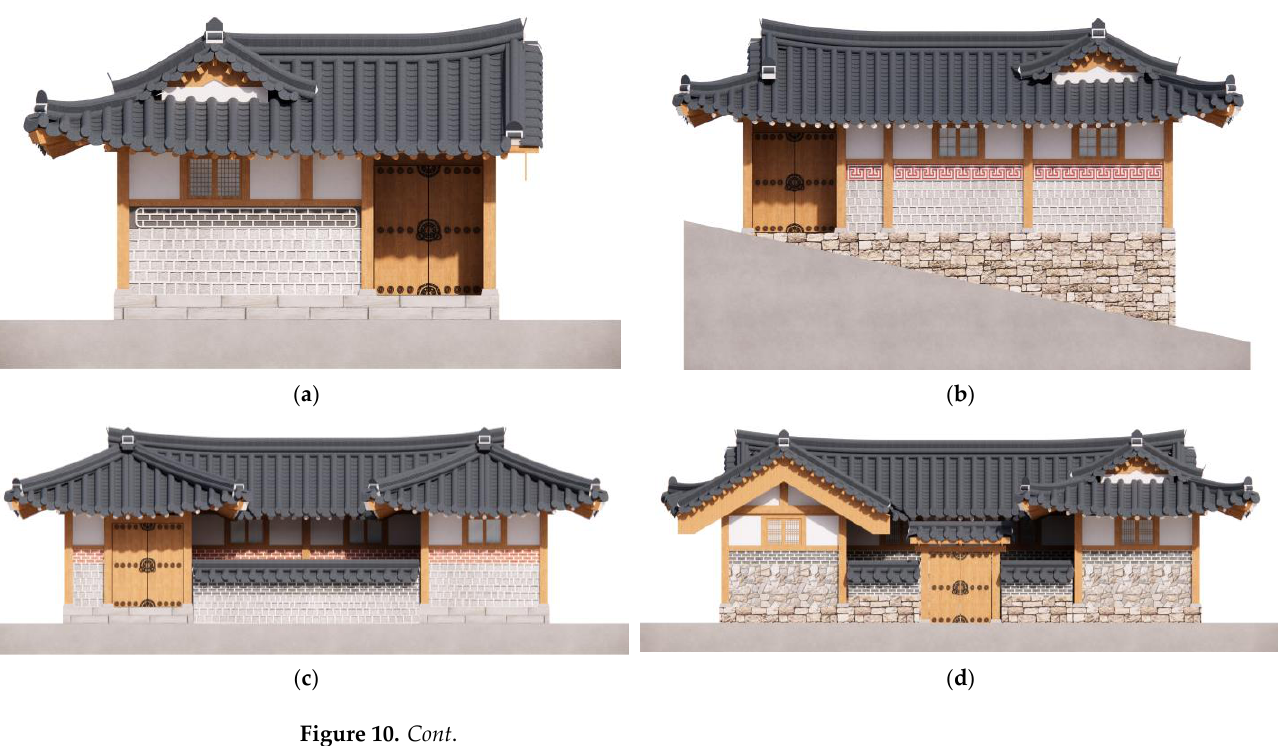
Figure 9. Location of the main gate in the facade (M) Reprinted/adapted with permission from Ref.